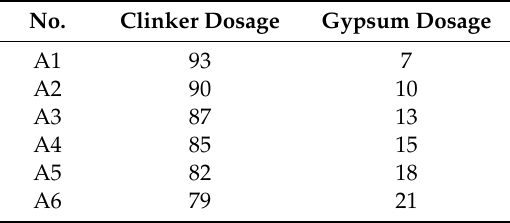
Table 3. Dosage design of gypsum in cement